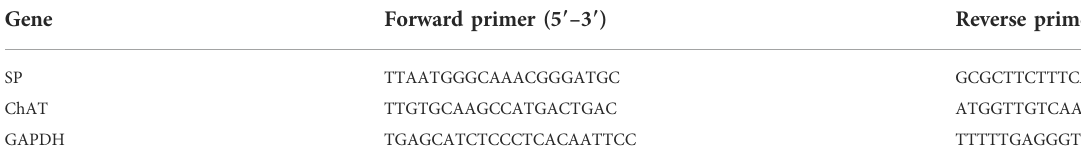
TABLE 2 Primer sequences.